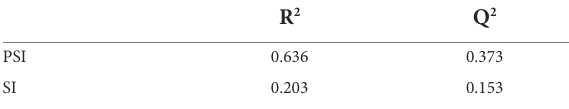
TABLE 7 R 2 and Q 2